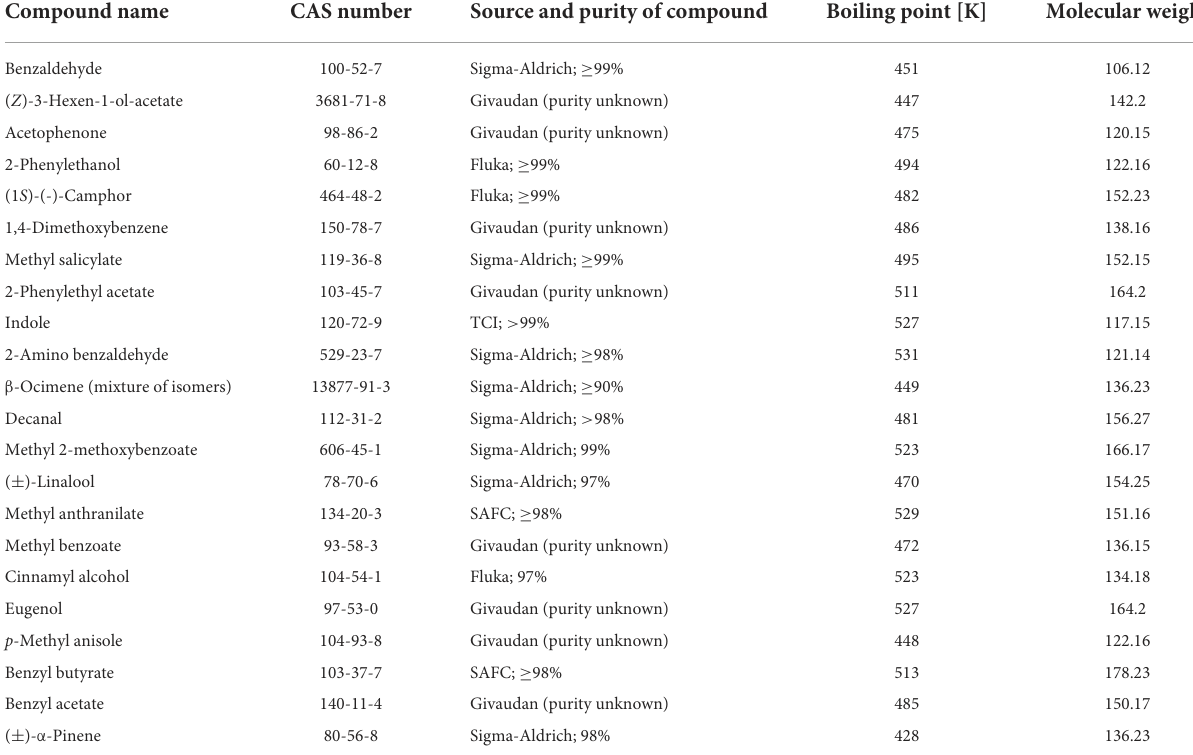
TABLE 1 Volatiles included in the